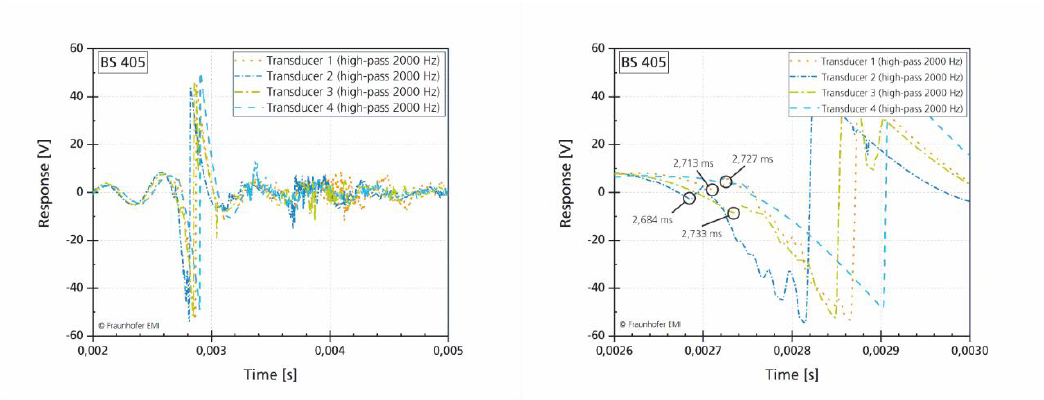
Fig. 8 Filtering of the measured signal for better identification (BS 405): Signal curve after filtering with a 2000 Hz high-pass filter (left); section of the measurement range with identified discontinuities in the measurement signal